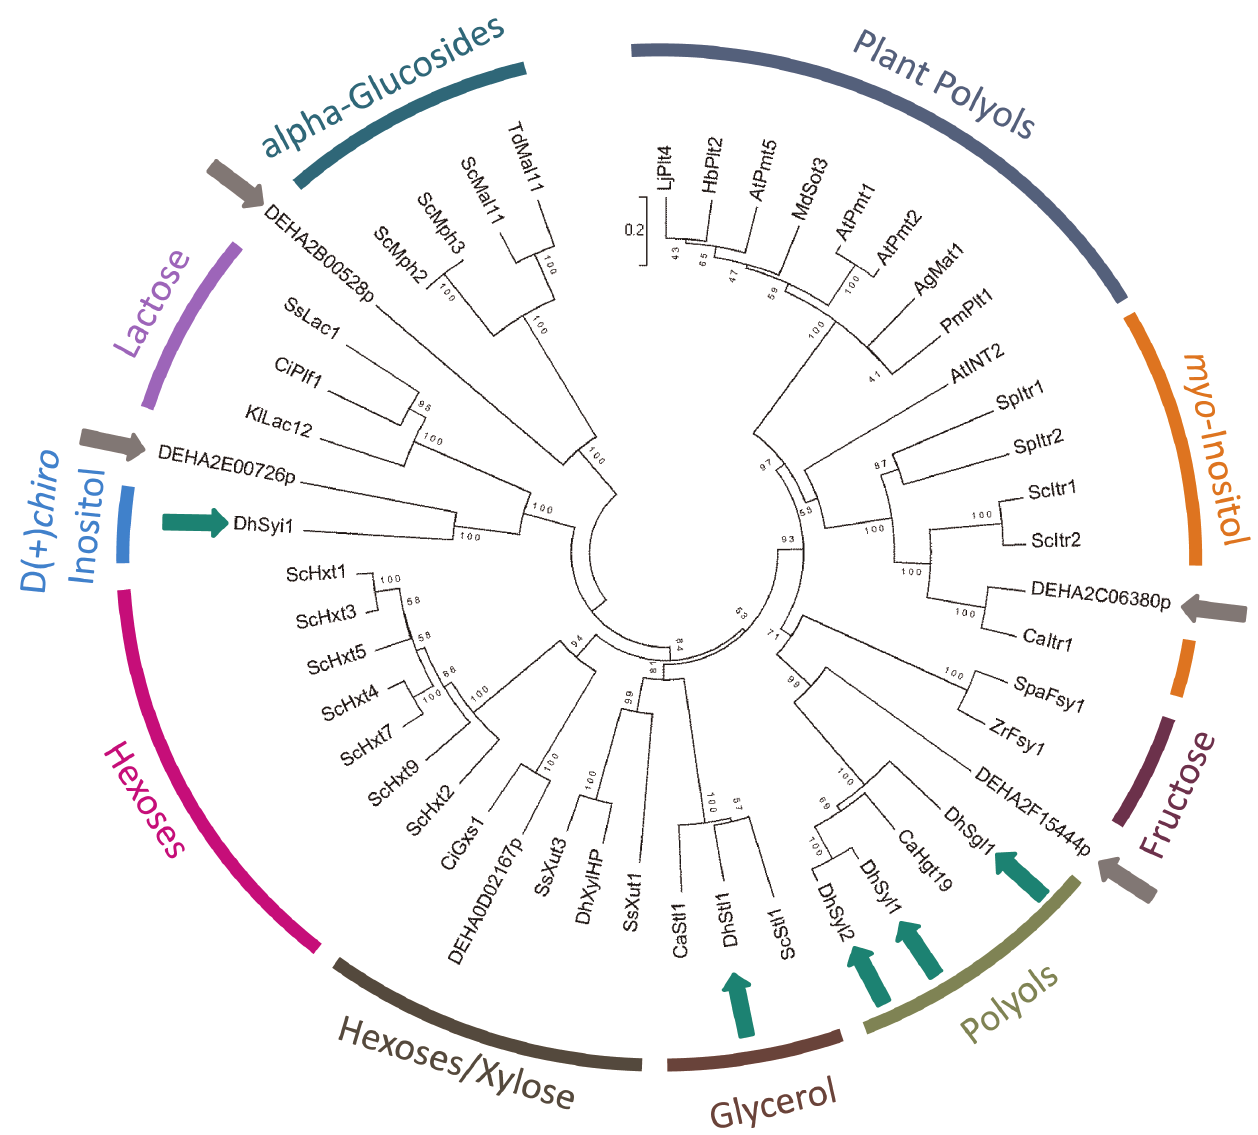
Figure 6. Dendrogram based on primary protein sequence homology using the neighbor-joining method (applied to 1000 bootstrap data sets). Dendrogram depicting the phylogenetic relationship between the characterized five new polyol transporters (green arrows), the four cloned putative transporters with unknown substrate (gray arrows) and other members of the Sugar Porter family. Represented proteins (and corresponding accession numbers) are: Ag Mat1- Apium graveolens mannitol transporter (AAG43998.1); At INT2- Arabidopsis thaliana inositol transporter 2 (CAJ00304.1); At Pmt1- A. thaliana polyol/monosaccharide transporter 1 (AEC06467.1); At Pmt2- A. thaliana polyol/monosaccharide transporter 2 (AEC06468.1); At Pmt5- A. thaliana polyol transporter 5 (NP_188513.1); Ca Itr1- C. albicans myo -inositol transporter 1 (XP_714885.1); Ca Hgt19- C. albicans potential myo -inositol transporter (XP_717819.1); Ca Stl1- C. albicans glycerol permease Ca O19.5753 (XP_718089.1); Ci Gxs1- C. intermedia glucose/xylose/H + symporter 1 (CAI44932.1); Ci Plf1- C. intermedia putative lactose facilitator 1 (CAO79524.1); DEHA0D02167p- D. hansenii DEHA2D01474p hexose transporter (XP_458532.1); DEHA2B00528p- D. hansenii putative transporter (CAG84972.1); DEHA2C06380p- D. hansenii putative transporter (CAG86022.1); DEHA2E00726p- D. hansenii putative transporter (CAG87550.2); DEHA2F15444p- D. hansenii putative transporter (CAG89402.1); Dh Sgl1- D. hansenii galactitol/H + symporter 1 (DEHA2E24310p; CAG88649.2); Dh Stl1- D. hansenii glycerol/H + symporter 1 (DEHA2E01386p; CAG87598.2); Dh Syi1- D. hansenii D-( + )- chiro -inositol/H + symporter 1 (DEHA2G06490p; CAG90290.2); Dh Syl1- D. hansenii sorbitol/ mannitol/ribitol/arabitol/galactitol/H + symporter 1 (DEHA2C05896p; CAR65543.1); Dh Syl2- D. hansenii sorbitol/mannitol/ribitol/arabitol/H + symporter 2 (DEHA2C05918p; CAG86001.1); Dh XylHP- D. hansenii DEHA2C11374p hexose/xylose transporter (XP_458169.1); Hb Plt2- Hevea brasiliensis putative polyol transporter protein 2 (CAP58707.1); Kl Lac12- Kluyveromyces lactis lactose permease (XP_452193.1); Lj Plt4 - Lotus japonicus putative polyol transporter protein 4 (CAJ29291.1); Md Sot3- Malus domestica sorbitol transporter (BAD42343.1); Pm Plt1- Plantago major polyol transporter (CAD58709.1); Sc Itr1- S. cerevisiae myo -inositol transporter 1 (DAA12329.1); Sc Itr2- S. cerevisiae myo -inositol transporter 2 (DAA10681.1); Sc Hxt1- S. cerevisiae hexose transporter 1 (DAA06789.1); Sc Hxt2- S. cerevisiae hexose transporter 2 (AAA34701.1); Sc Hxt3- S. cerevisiae hexose transporter 3 (DAA12185.1); Sc Hxt4- S. cerevisiae hexose transporter 4 (DAA06788.2); Sc Hxt5- S. cerevisiae hexose transporter 5 (DAA06790.1); Sc Hxt7- S. cerevisiae hexose transporter 7 (DAA12183.1); Sc Hxt9- S. cerevisiae hexose transporter 9 (NP_012316.1); Sc Mal11- S. cerevisiae maltose (alpha-glucoside) transporter (DAA08377.1); Sc Mph2- S. cerevisiae alpha-glucoside permease 2 (DAA11620.1); Sc Mph3- S. cerevisiae alpha-glucoside permease 3 (DAA08944.1); Sc Stl1- S. cerevisiae glycerol/H + symporter 1 (DAA12366.1); Sp Itr1- Schizosaccharomyces pombe myo -inositol transporter 1 (CAA67211.1); Sp Itr2- Schi. pombe myo -inositol transporter 2 (NP_593320.1); Spa Fsy1- S. pastorianus fructose/H + symporter (CAC08232.1); Ss Lac1-